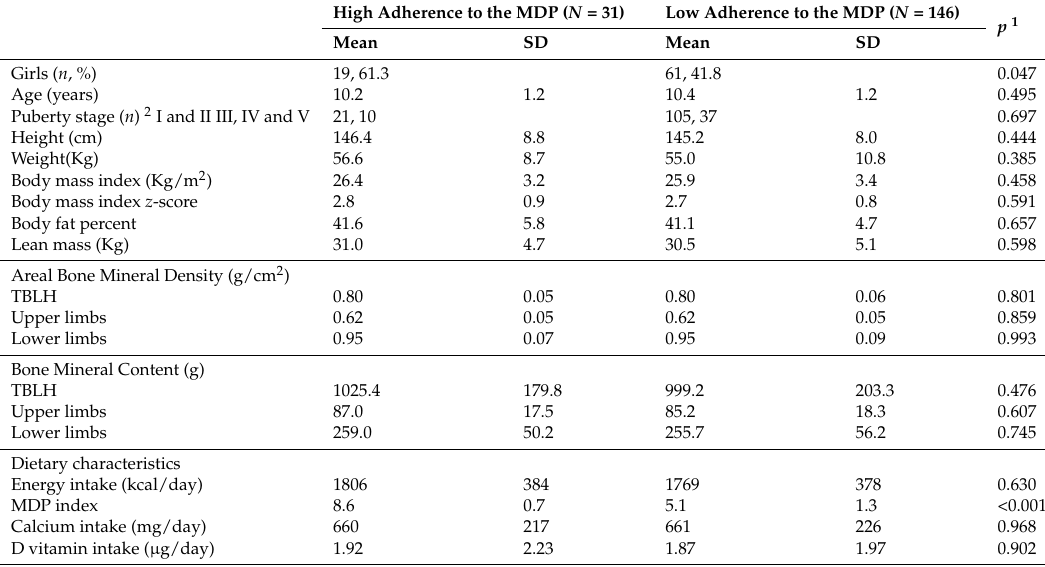
1 Analyzed by Student t -test, 2 Some missing data in the low adherence groups N = 4. TBLH: total bone mineral content of body less head. Upper limbs: average of both arms. Lower limbs: average of both legs. MDP index: Adherence to the Mediterranean dietary pattern index, High adherence to the Mediterranean diet pattern index: MDP index ≥8; Low adherence to the Mediterranean dietary pattern: MDP index <8; SD: standard deviation.